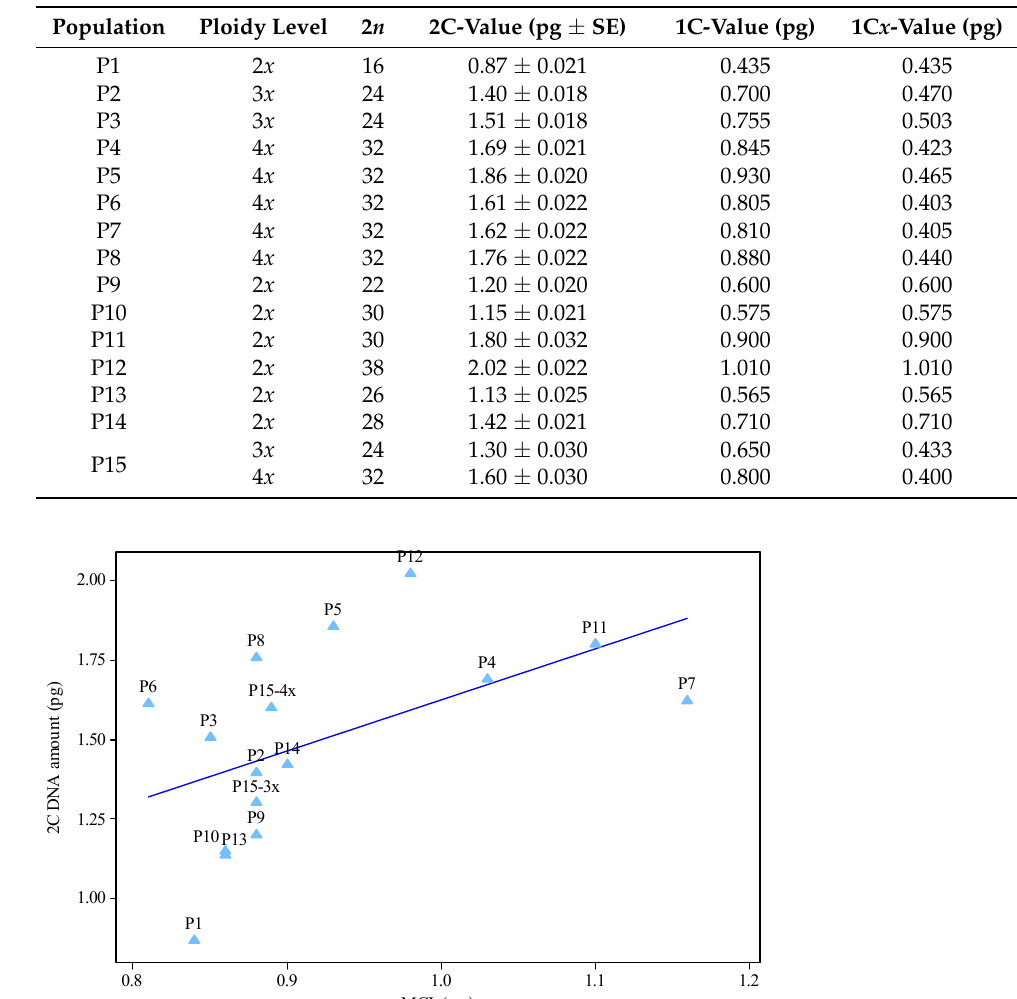
Table 2. 2C DNA value (pg) of 15 Hypericum perforatum populations.